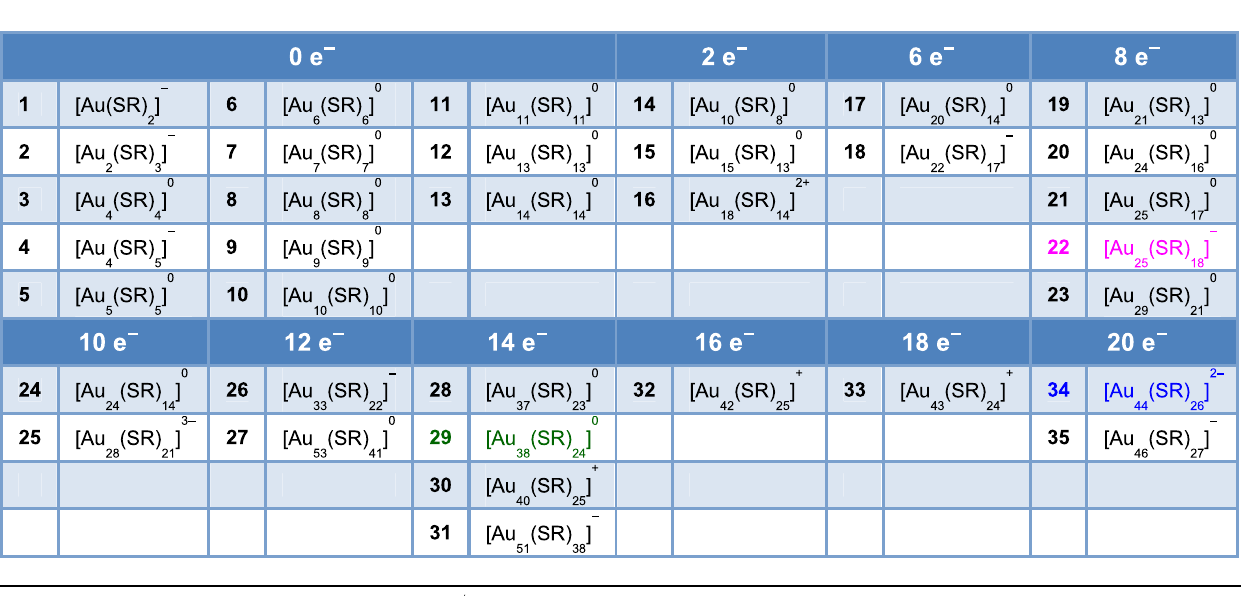
Table 1). Zoom-in ESI-MS spectra and the isotope patterns of all these species are included in Figs. 1d, e, and